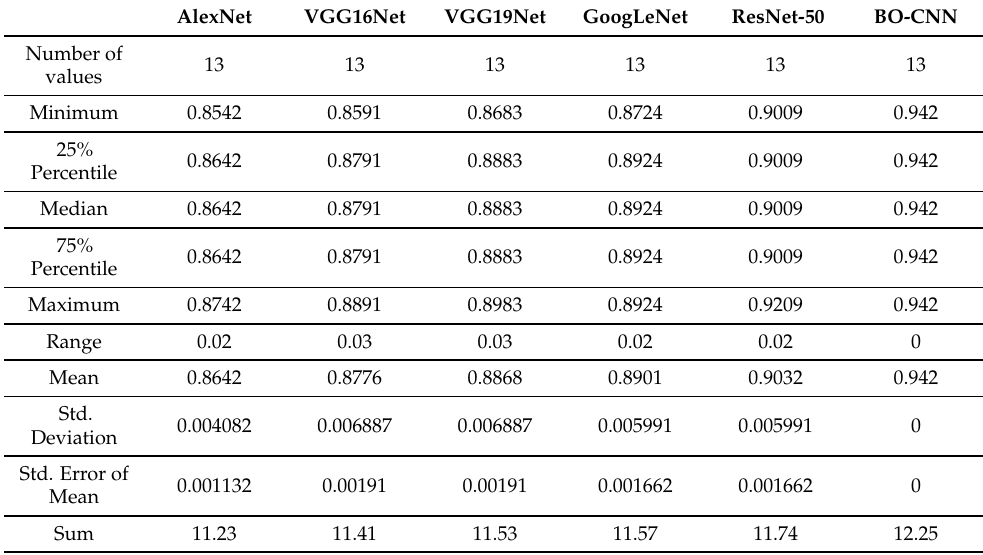
Table 8. Statistical description of the proposed BO-CNN model vs. pre-trained-CNN models for the IDRiD dataset.